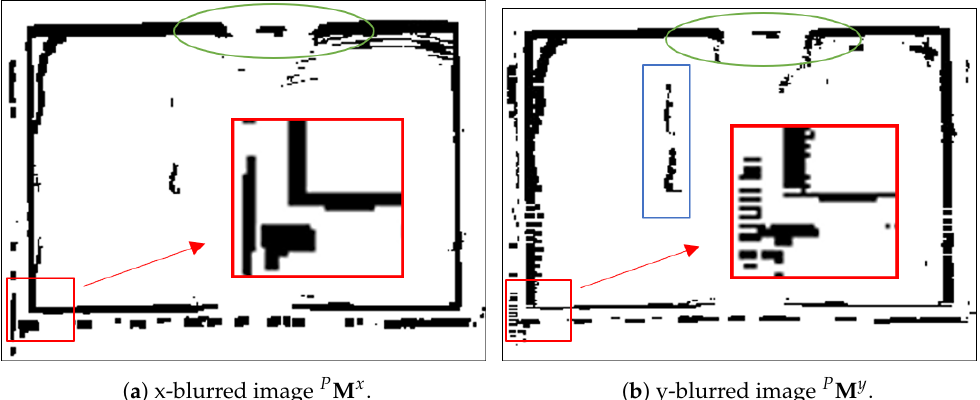
Figure 9. Rasterization images. The x axis is horizontal. The y axis is vertical. The green ellipses mark the same area as in Figure